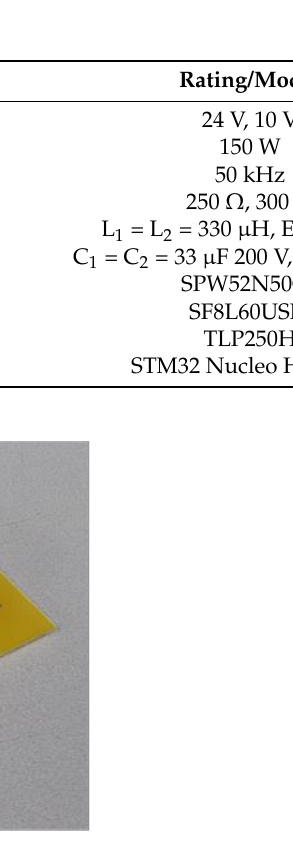
Figure 7. Prototype of the proposed converter.